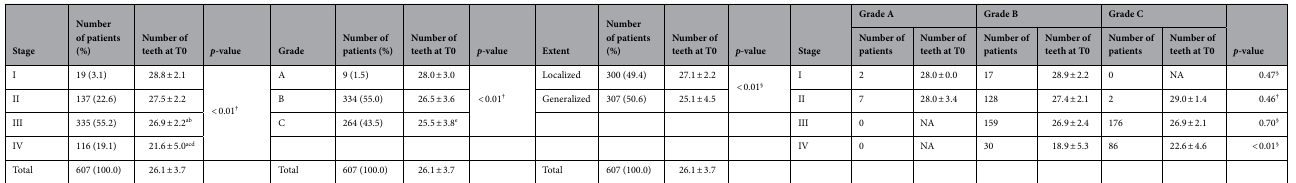
Table 2. Number of teeth at baseline by stage, grade, and extent. Statistical analysis comparing three or four groups according to the number of teeth was performed with the Kruskal–Wallis test followed by the Steel–Dwass post hoc test. Statistical analysis comparing two groups according to the number of teeth was performed with the Mann–Whitney U test. T0, start of APT. Number of teeth at T0 is shown as mean ± standard deviation. † p -value from the Kruskal–Wallis test. § p -value from the Mann–Whitney U test. Significant difference by the Steel–Dwass post hoc test compared with Stage I ( p < 0.01:a), Stage II ( p < 0.05:b, p < 0.01:c), Stage III ( p < 0.01:d), and Grade B ( p < 0.01:e).